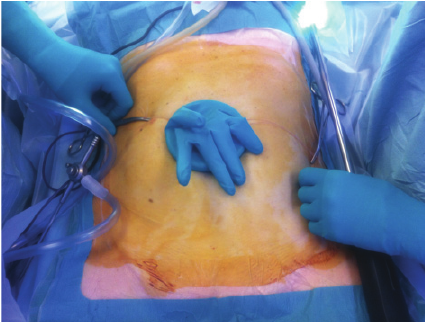
Figure 2: Placement of surgical glove.